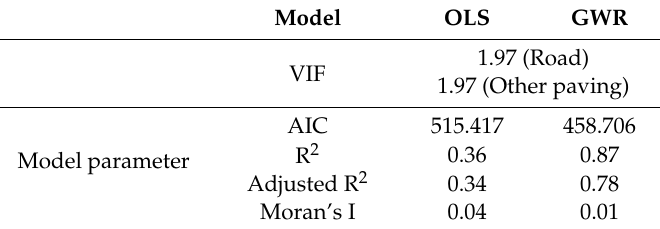
Table 2. Comparison of OLS and GWR model results.